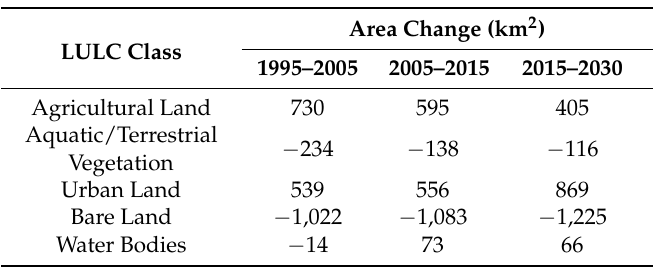
Table 3. LULC classes change (gains and losses) over the Nile Delta from 1995 to 2030 (Business As Usual, BAU).